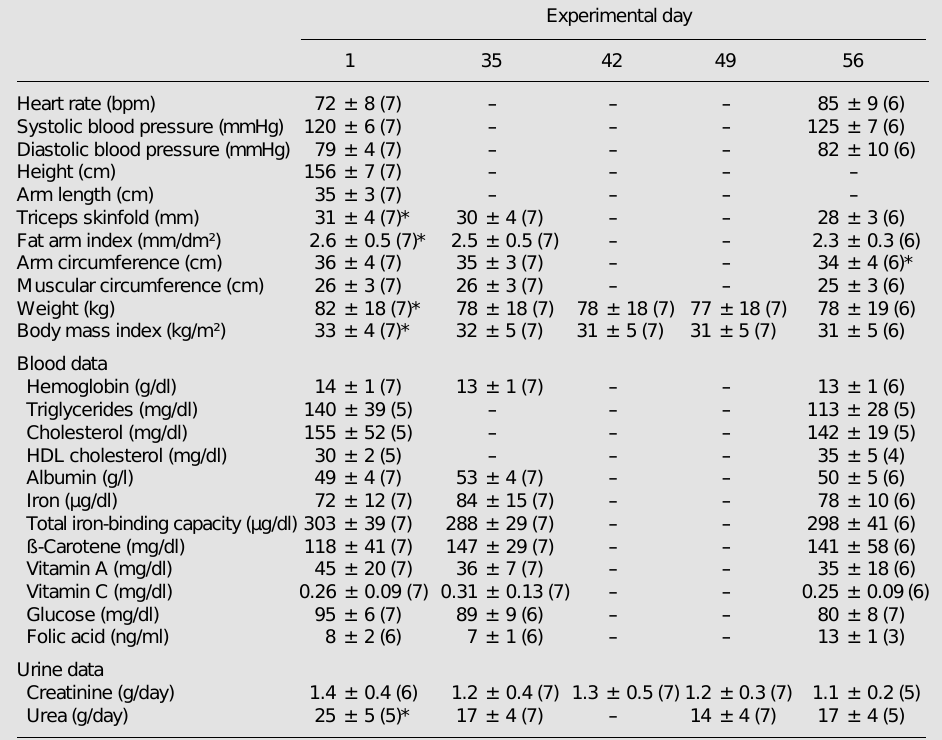
Data are reported as means ± SD, with the number of subjects given in parentheses. *P<0.01 compared to day 1 (ANOVA/Tukey test). Fat arm index = triceps skinfold/arm length; muscular circumference = arm circumference - p triceps skinfold; body mass index = weight/height.